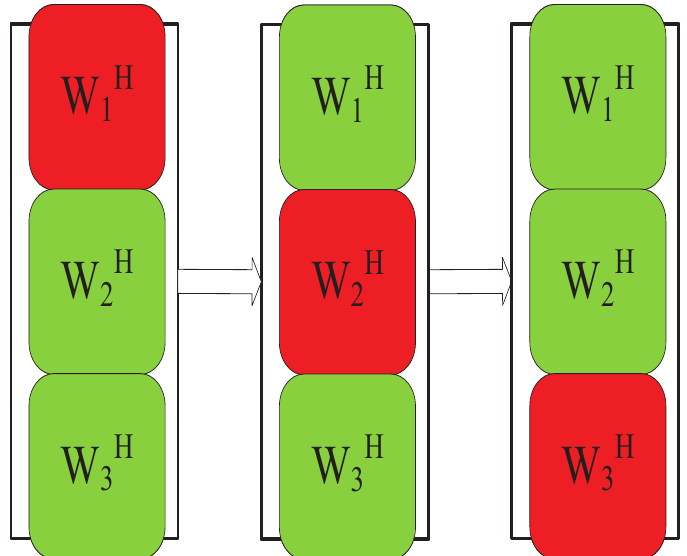
Figure 6. IP update